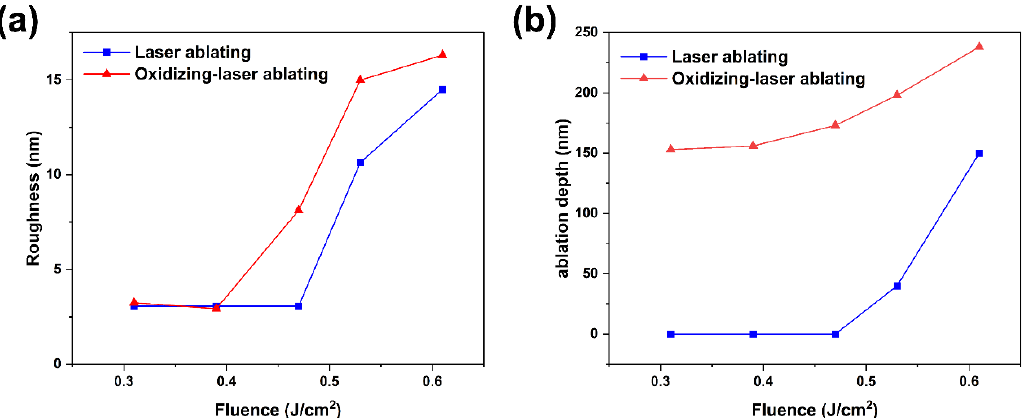
oxidized (90 W, 30 min) Cu films as a function of laser fluence.